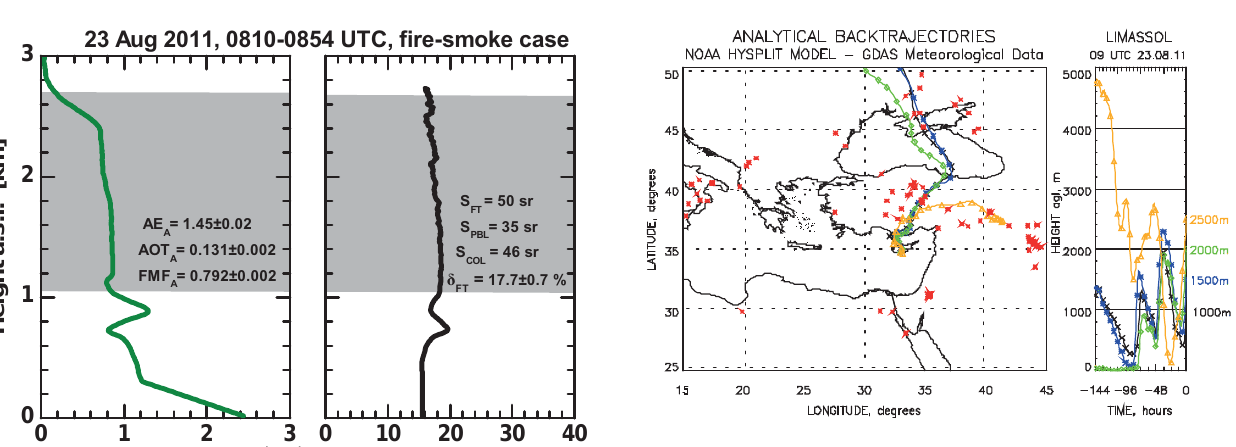
Figure 5. Same as Fig. 3, except for 23 August 2011. Red crosses indicate fire events which occurred during the time period from 16 to 23 August 2011.